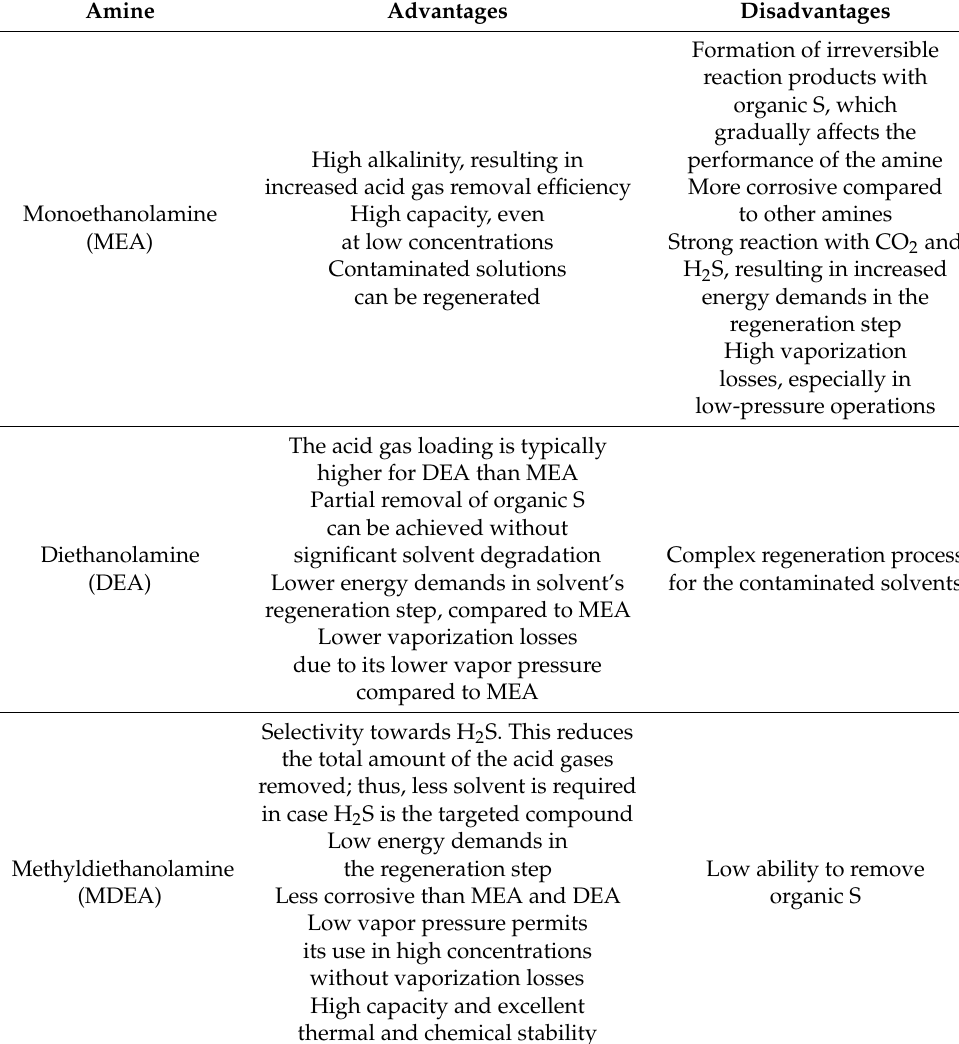
Table 6. Summary of advantages and disadvantages of the main